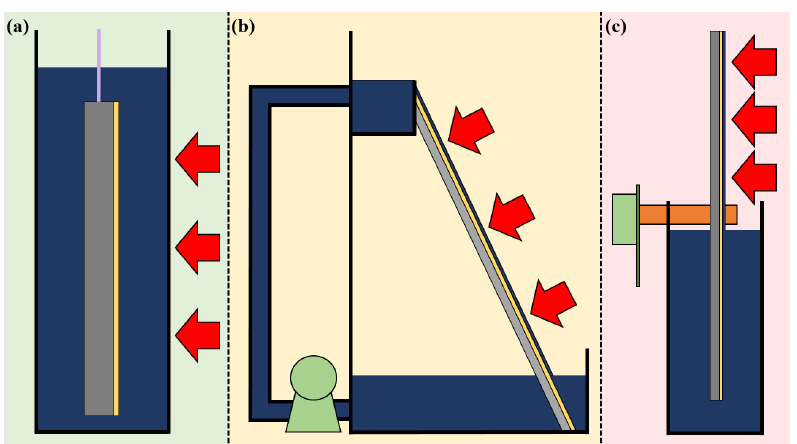
Figure 3. Schematic diagrams of ( a ) immersed photocatalytic reactor, ( b ) inclined plate thin solution film photocatalytic reactor, and ( c ) rotating disk thin solution film photocatalytic reactor.